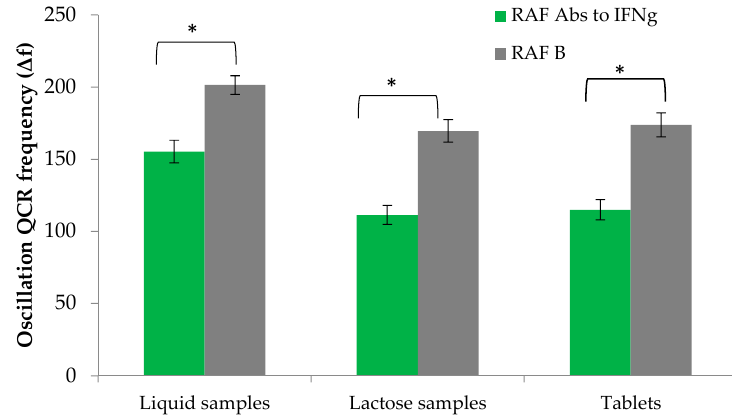
Figure 1. Intermediate precision: analytical signals of test samples and differences of RAF Abs to IFNg ( green ) versus control ( grey ) as measured by three operators over a 10-day period ( n = 150. p = 0.95). The full data is presented in the Supplementary Table S4. * means Pr > F is < 0.0001.